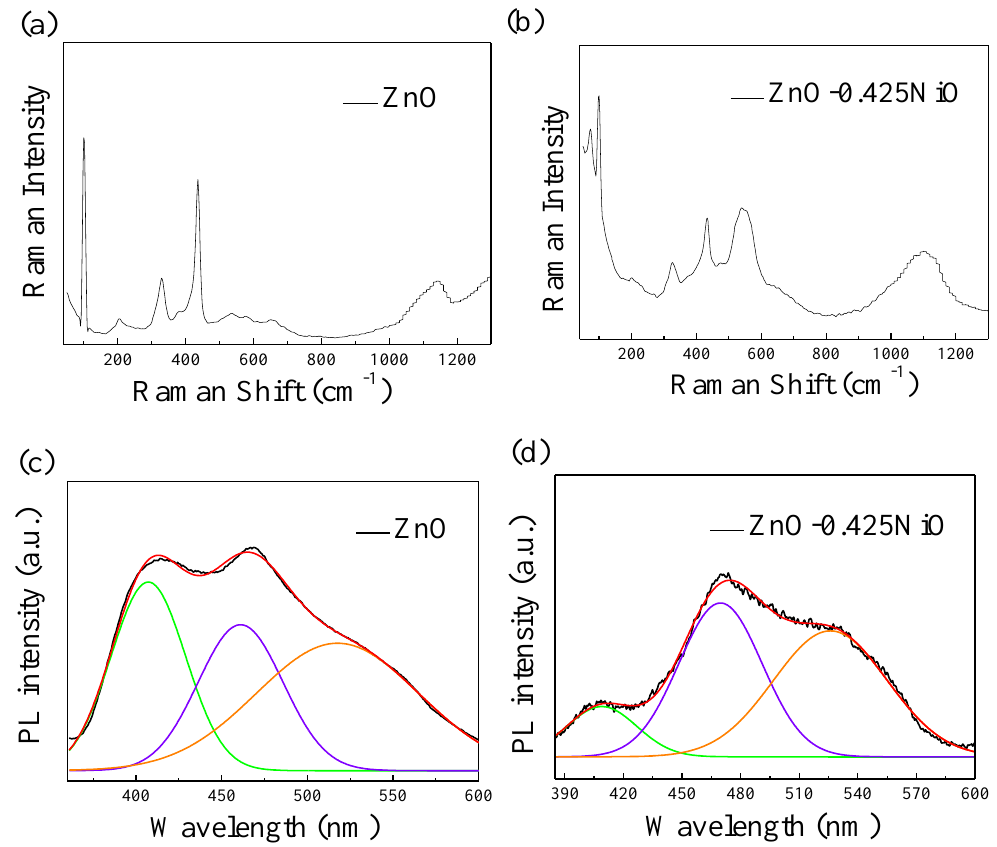
Figure 5. Raman spectra of the ( a ) pristine ZnO and ( b ) ZnO–0.425NiO composite annealed at 550 ◦ C;